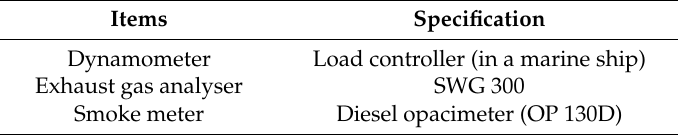
Table 3. Specifications of the engine dynamometer and exhaust analyser.